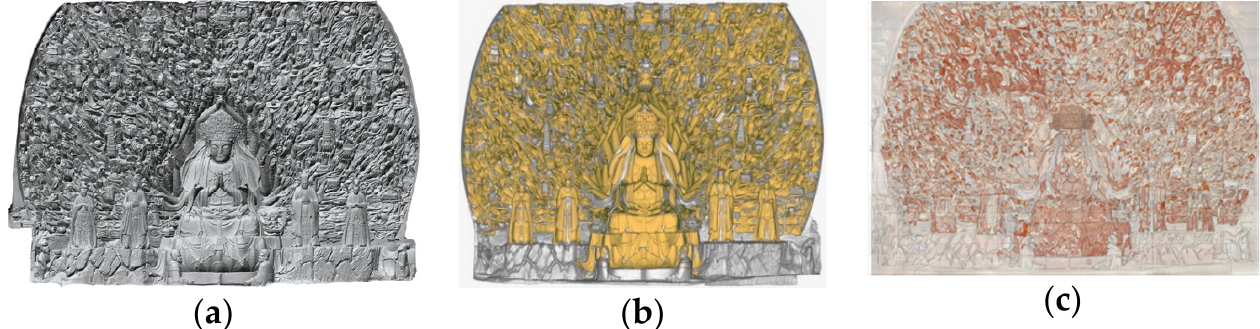
Figure 8. ( a ) LOD2—3D mesh of the Dazu Thousand-Hand Bodhisattva Statue in 2011; ( b ) the gilded area in yellow in 2011; ( c ) the damaged area of gold leaf in red.